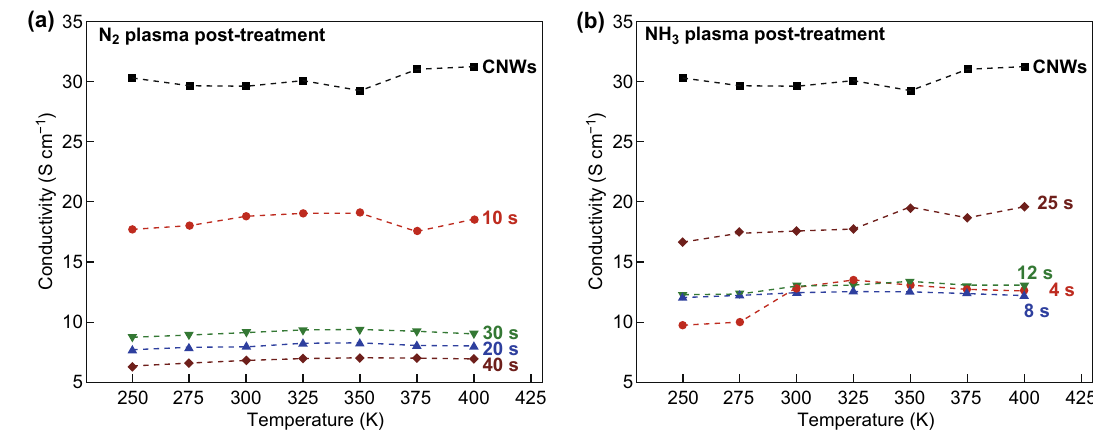
Fig. 9 a , b Temperature-dependent electrical conductivity of CNW and N-CNWs: a after N 2 , and b after NH 3 plasma